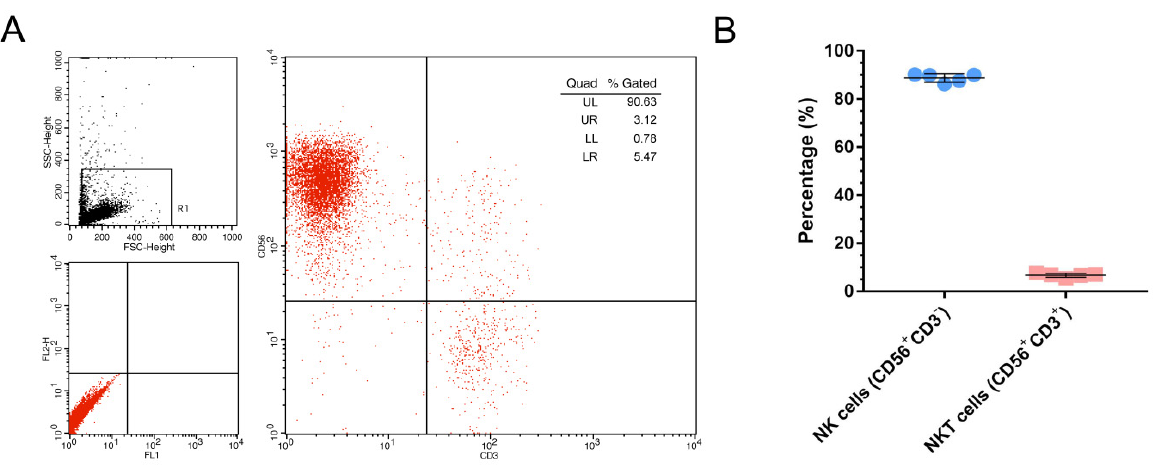
Figure 2. The proportion of NK cells. ( A ): The representative flow cytometry data of NK cells (CD56 + CD3 − ) proportion. ( B ): The statistical results of NK cells (CD56 + CD3 − ) and NKT (CD56 + CD3 + ) cells proportion (n =